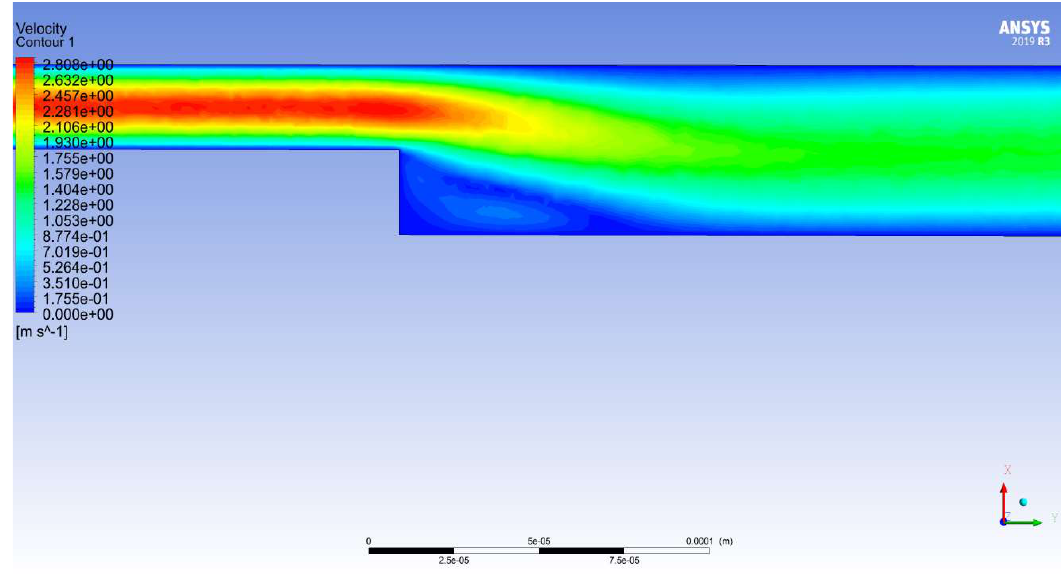
Figure 10. Velocity distribution in the Reynolds Stress turbulence model.